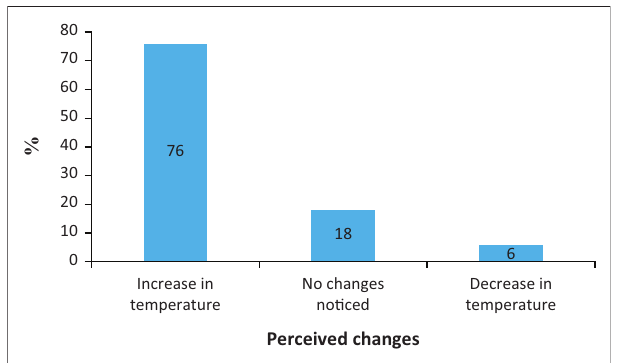
1 1. Increased rainfall (19 % ) 2. Reduced rainfall (59